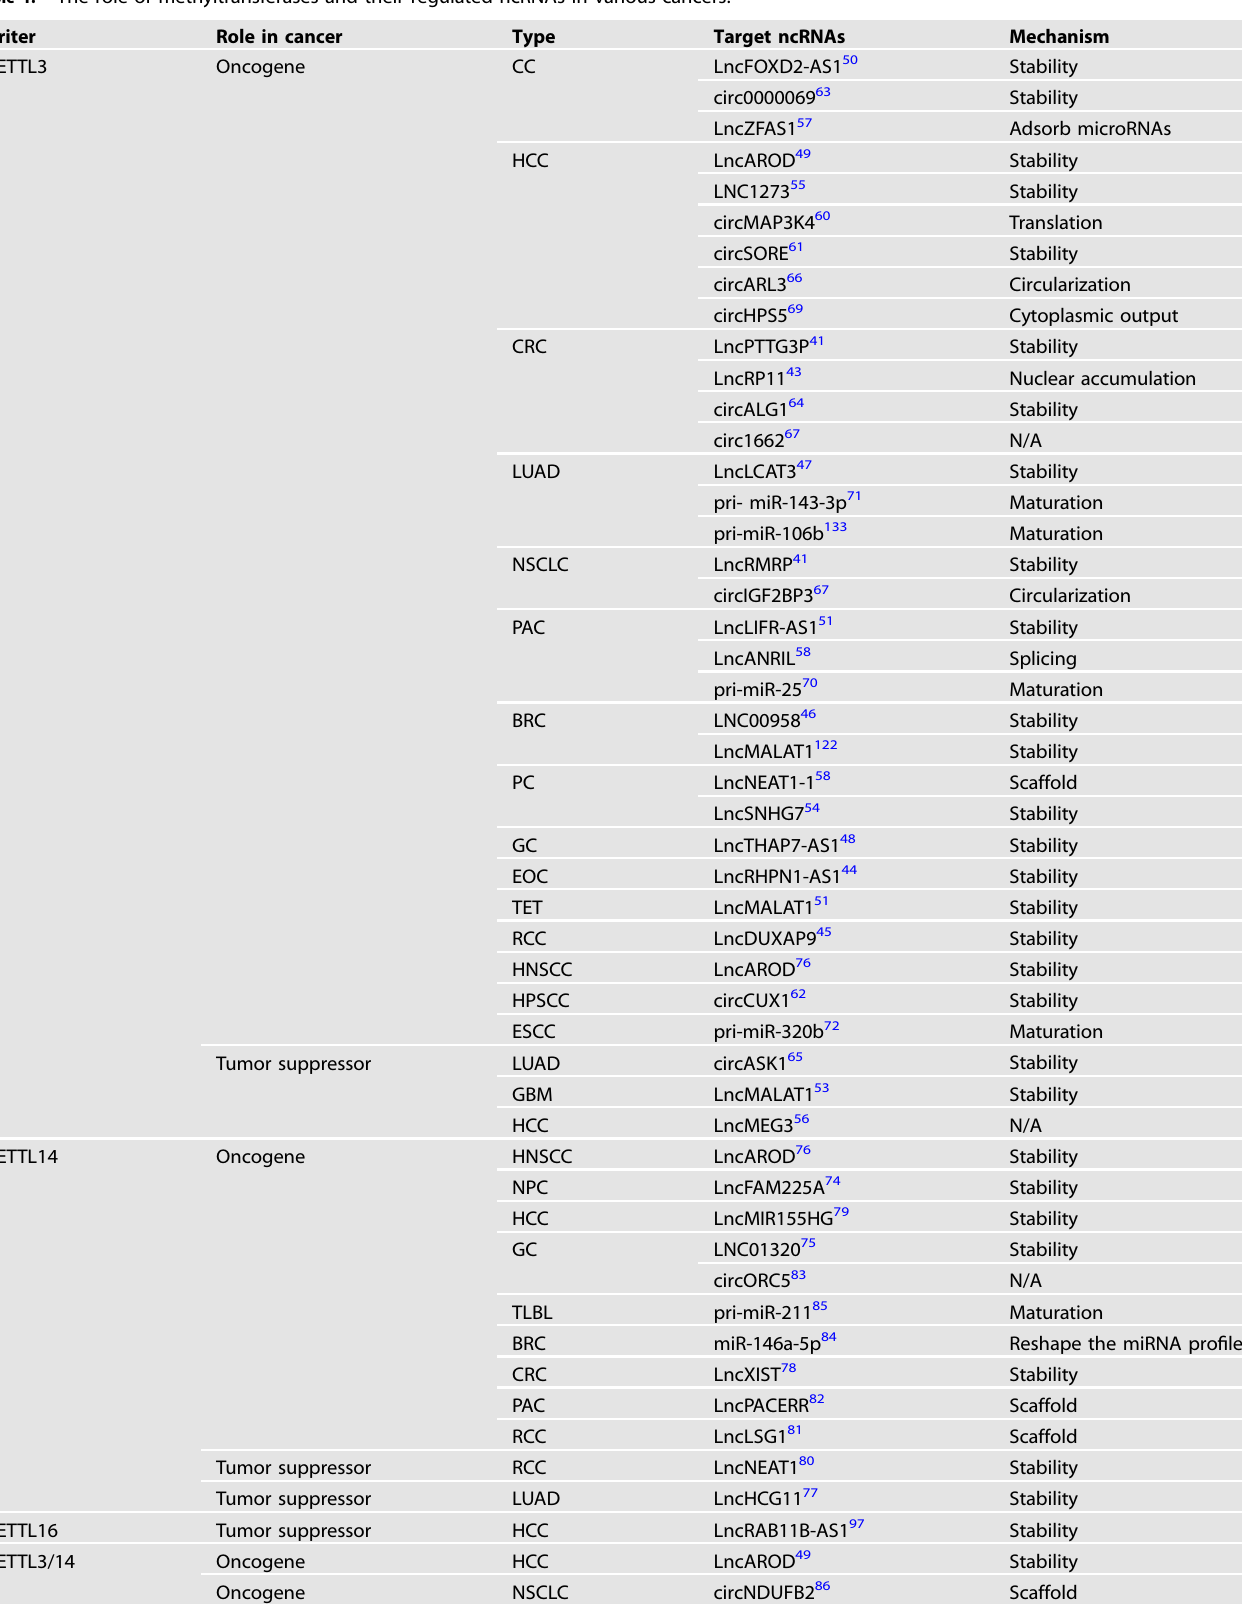
Table 1. The role of methyltransferases and their regulated ncRNAs in various